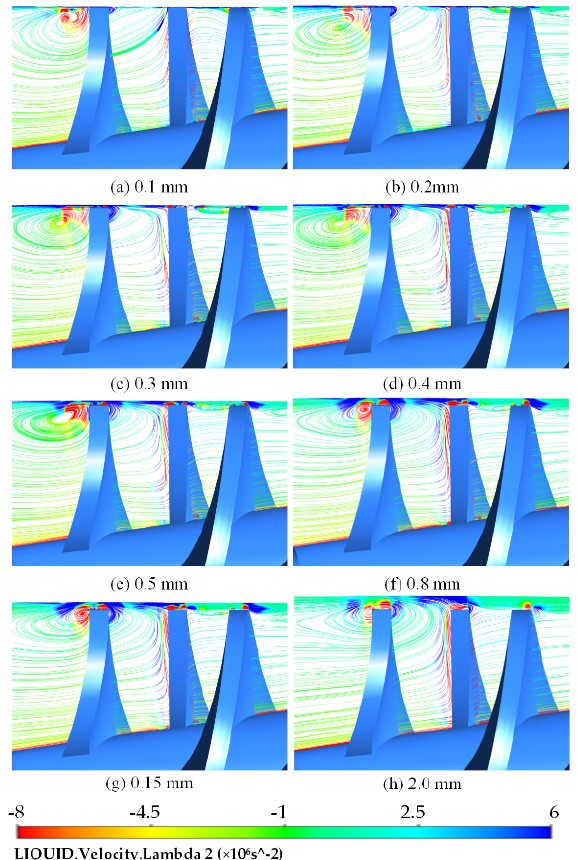
Figure 12. Streamline for λ 2 Criteria Shading for Each TC.